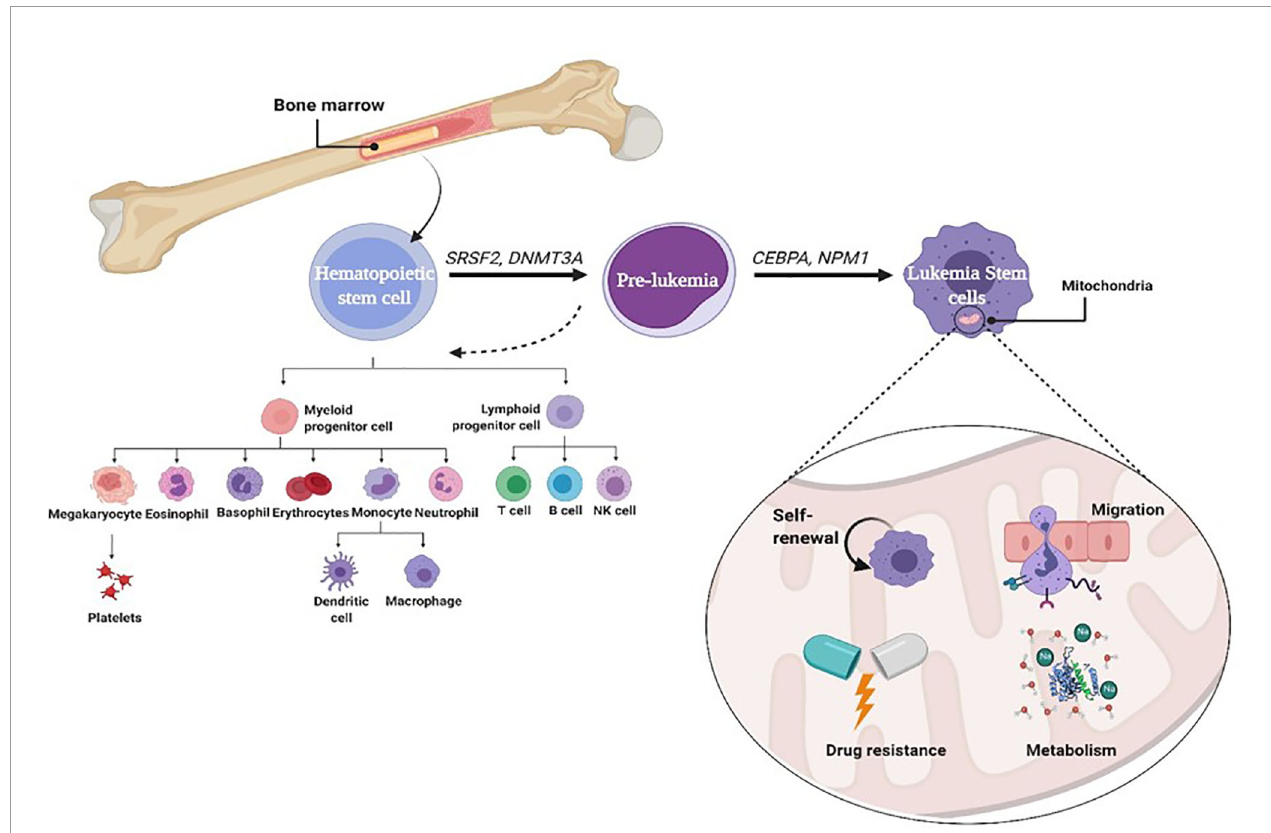
FIGURE 1 | Role of mitophagy in leukemia stem